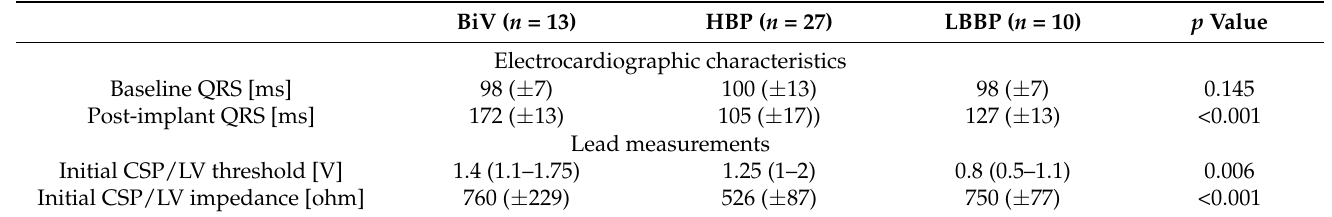
Table 2. Electrocardiographic characteristics at baseline and follow-up and initial device parameters by pacing modalities.